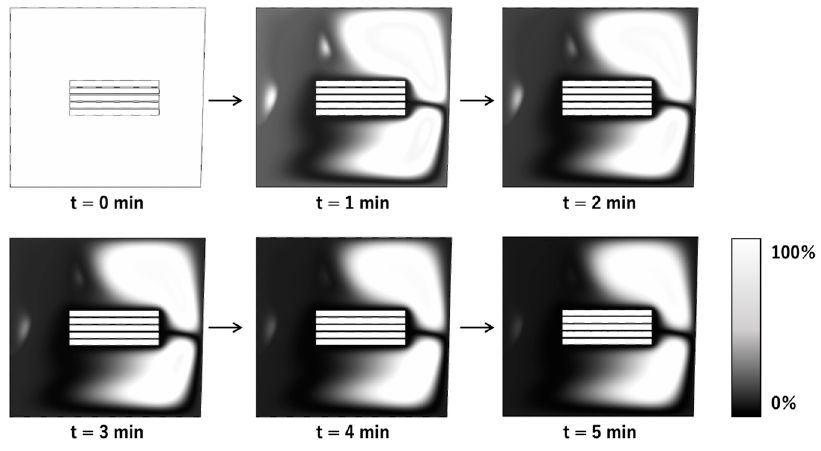
Figure 6. Calculated changes in concentration distribution of analytes in steady rotation conditions.